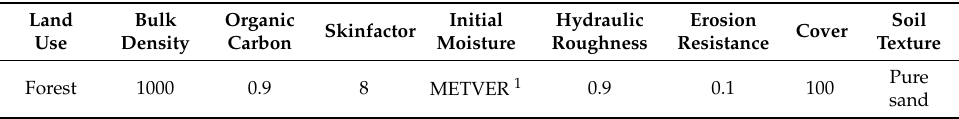
Table 2. The parameterization of an undisturbed forest.